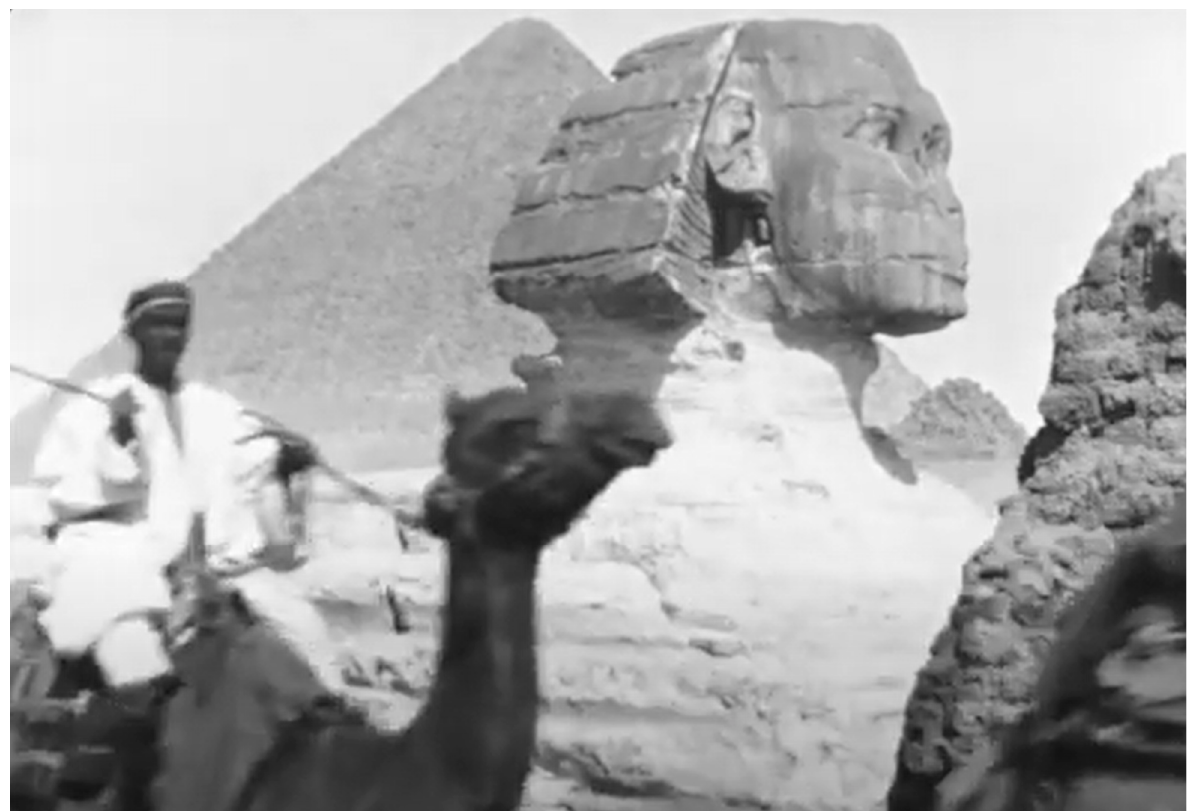
Figure 2. Screenshot from Alexandre Promio’s film Les Pyramides (vue générale). Vue N. 381 .